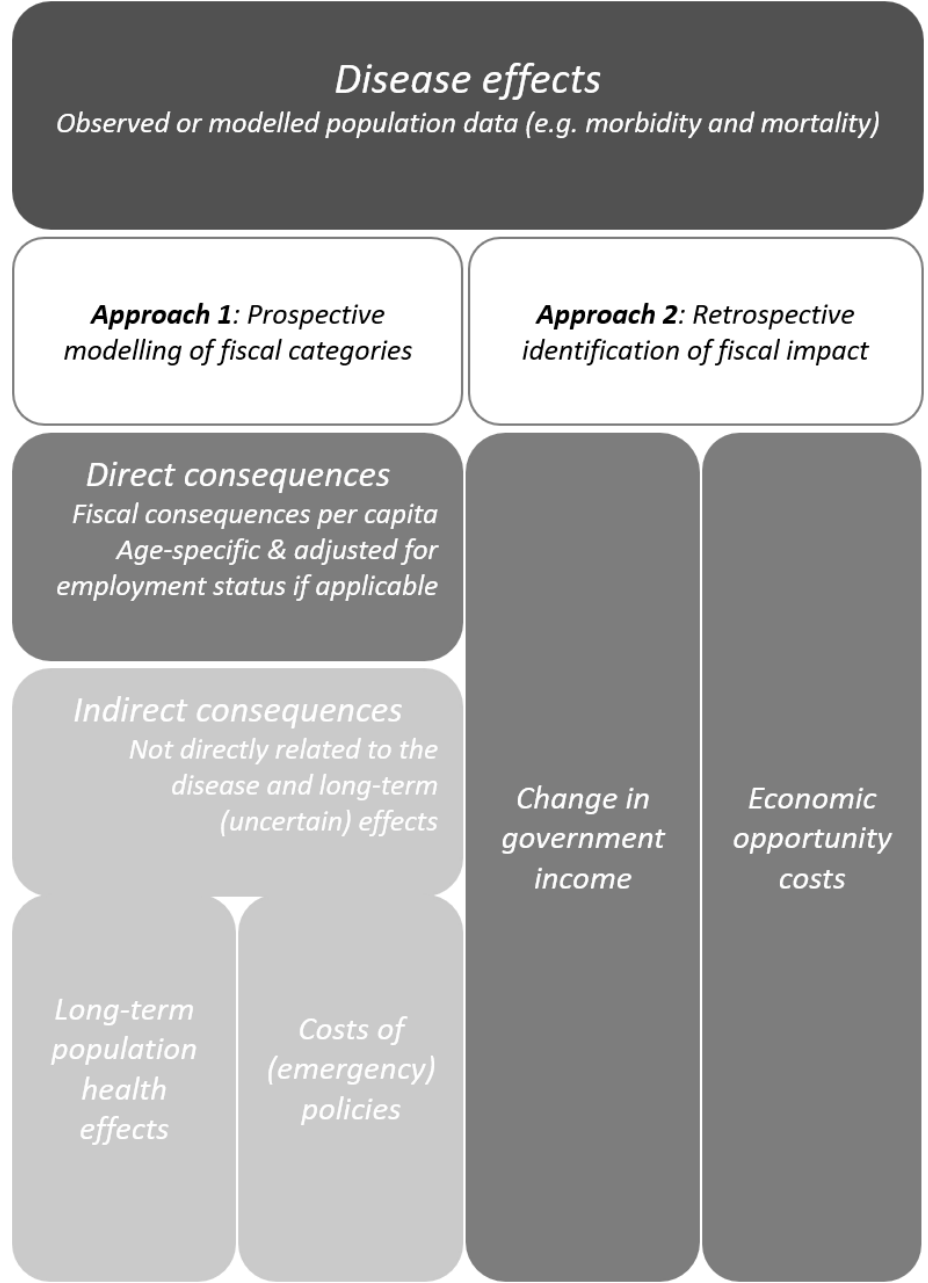
Figure 1. Framework schematic overview . The disease e ff ects (population data) of the fi rst analysis approach are depicted on the left of the fi gure. The alternative approach is shown on the right.